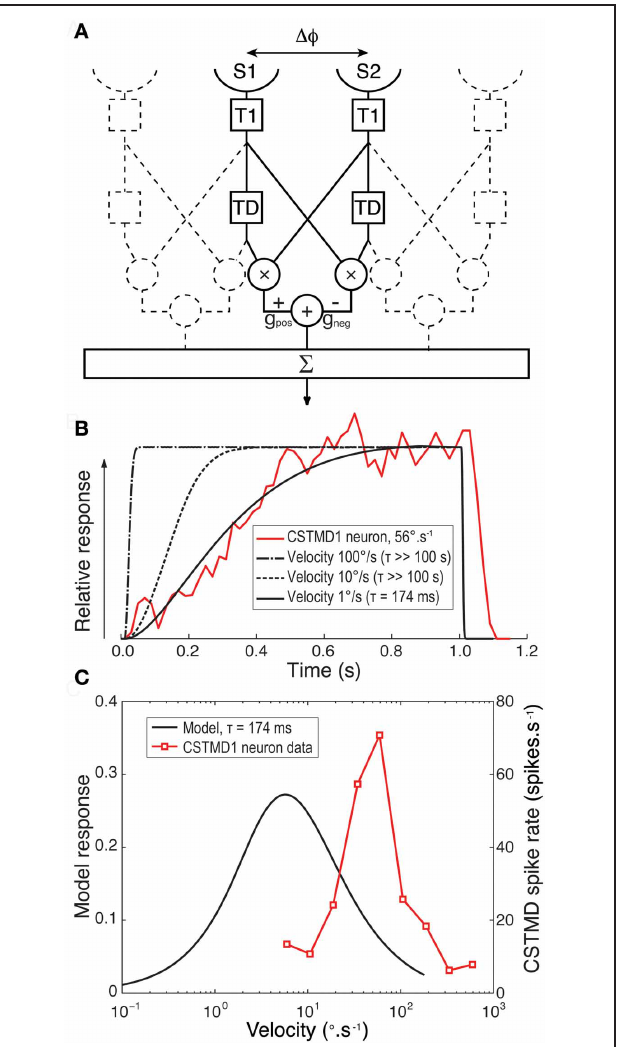
FIGURE 5 | (A) A block diagram for our computational model for an EMD array. For each EMD in the array two adjacent sensors (S1 and S2) with separation (cid:3) ϕ receive a luminance signal that is Gaussian blurred to represent the optics of the compound eye. Each signal arm is then convolved with a lognormal temporal filter (T1) that mimics the temporal properties of the insect photoreceptor. For a target moving left to right the output of S1 is then further convolved with an exponential delay filter (TD). The undelayed signal from S2 was multiplied by the delayed signal from the neighboring arm. This process was repeated in a mirror symmetrical fashion and the two outputs subtracted from each other with equal gain (G) to give an individual EMD’s response. Responses were then summed across the array traversed by the target. (B). Spatially normalized CSTMD1 response to a target commencing motion within the receptive field at at 56 ◦ .s − 1 reveals a time course that builds over hundreds of milliseconds (red line). The model EMD array was then fitted to this data with a delay time constant optimized to match this physiological response. An excellent fit (black line) is possible when modeling the response to a low target speed (1 ◦ .s − 1 ) with a long time constant ( τ = 174ms) for the delay filter (TD). However at faster target velocities (dashed lines) the model cannot fit the data and the model response rolls on too fast for even the largest time constants fitted ( > 100s) (C) Velocity tuning of the EMD model with a time constant of 174ms (black line) has a peak response at a speed 1/10th of that we previously observed from CSTMD1 (red line, Geurten et al.,